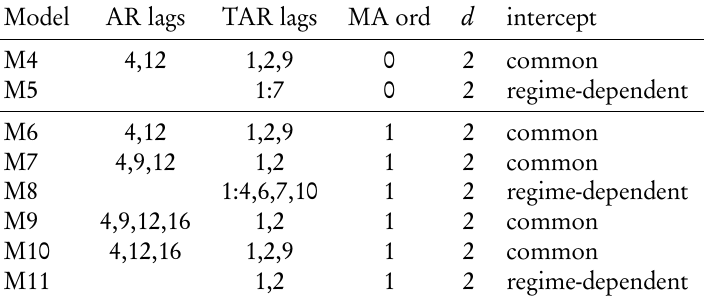
Models used to analyse the Canadian lynx time series. The “AR lags” column indicates the subset of lags whose parameters are fixed across regimes, whereas the “TAR lags” column refers to the subset of lags whore parameters are regime-dependent. Moreover, d is the delay parameter and “MA ord” is the moving-average order. The last column indicates whether the intercept is common between regimes or it is